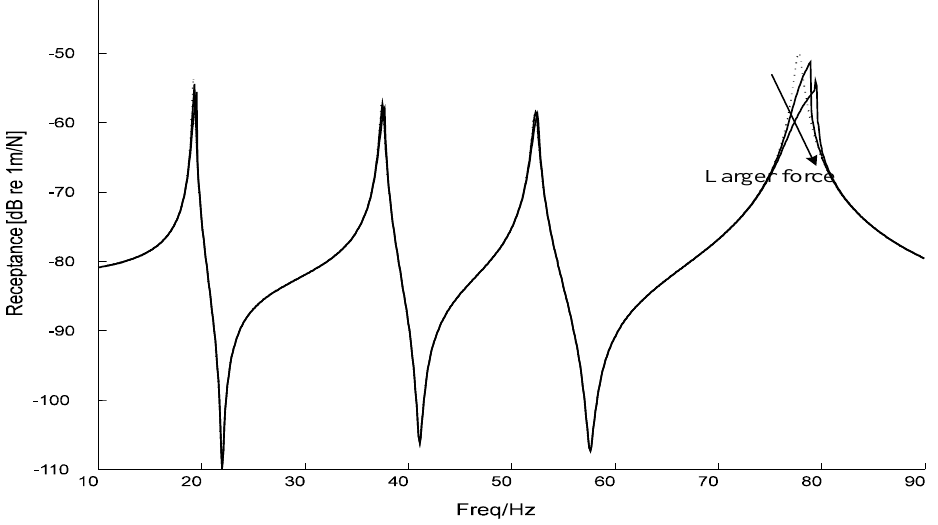
Fig. 2. Response of the 4 DOF system with cubic stiffness